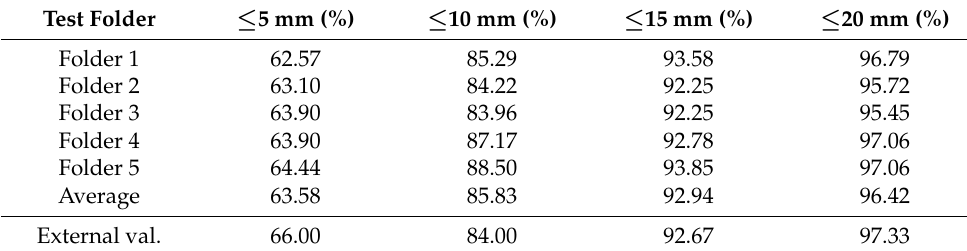
Table 2. The distance error distribution in ETT–Carina.